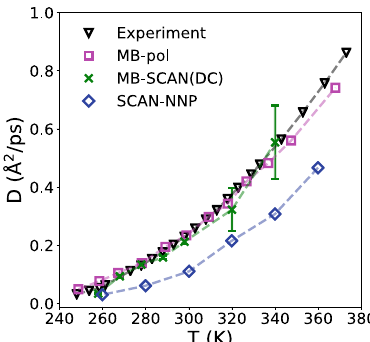
Fig. 6 Structure of liquid water. Oxygen − oxygen ( g OO ) radial distribution function (RDF) calculated from NPT simulations carried out with the MB- SCAN(DC) PEF at 298 K and 1 atm. The MB-pol RDF is from ref. 81 , while the experimental RDF at 295 K is from ref. 82